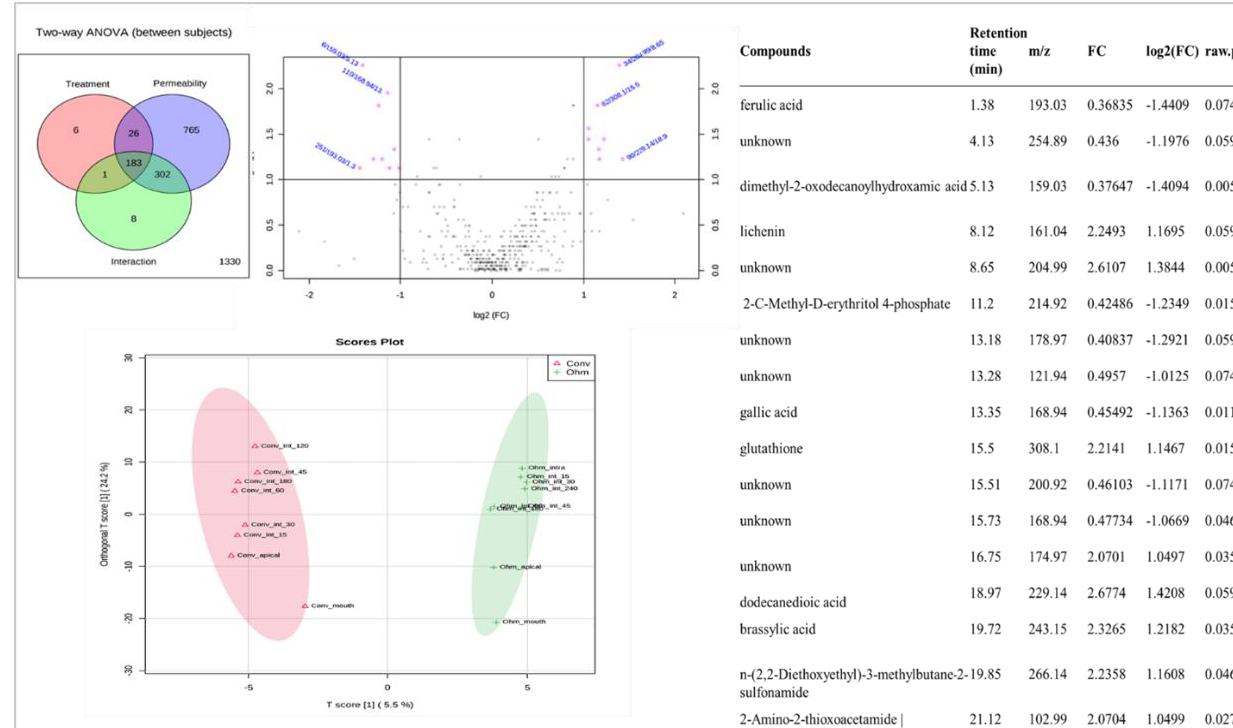
Figure 3. Metabolomic analysis, two-way ANOVA, OPLS-DA, and fold-change analysis.